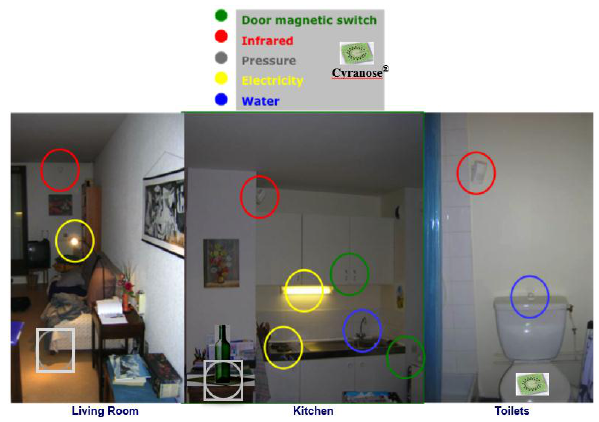
Figure 2. Sensors recording at home door opening (in green), pressure on the ground (white square) and under bottles and glasses (white square with circle inside), room activity with infrared sensors (in red), water (in blue) and electricity consumption (in yellow).